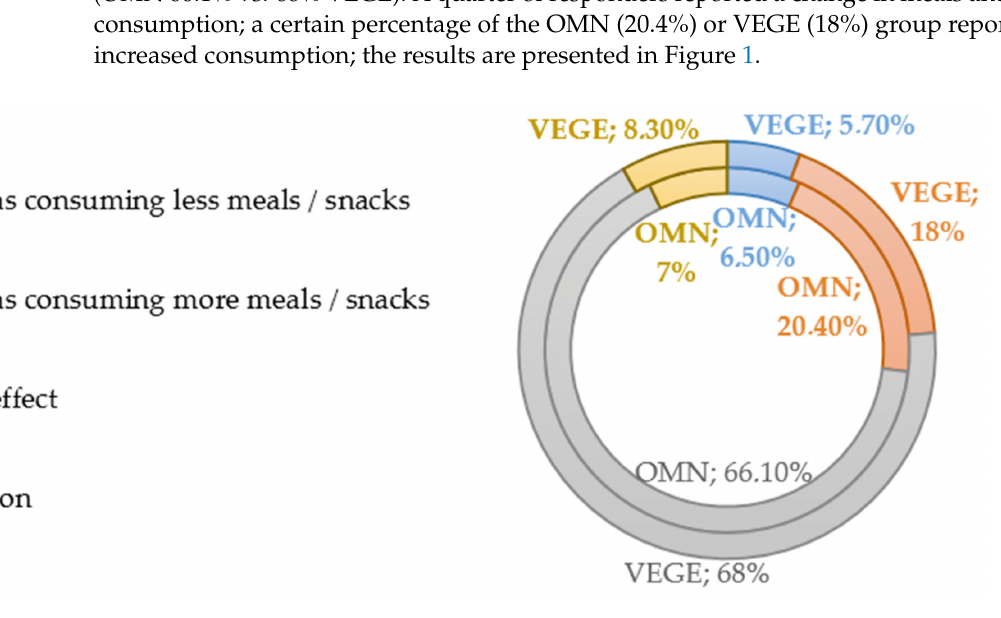
Figure 1. Changes in consumption of food during the COVID-19